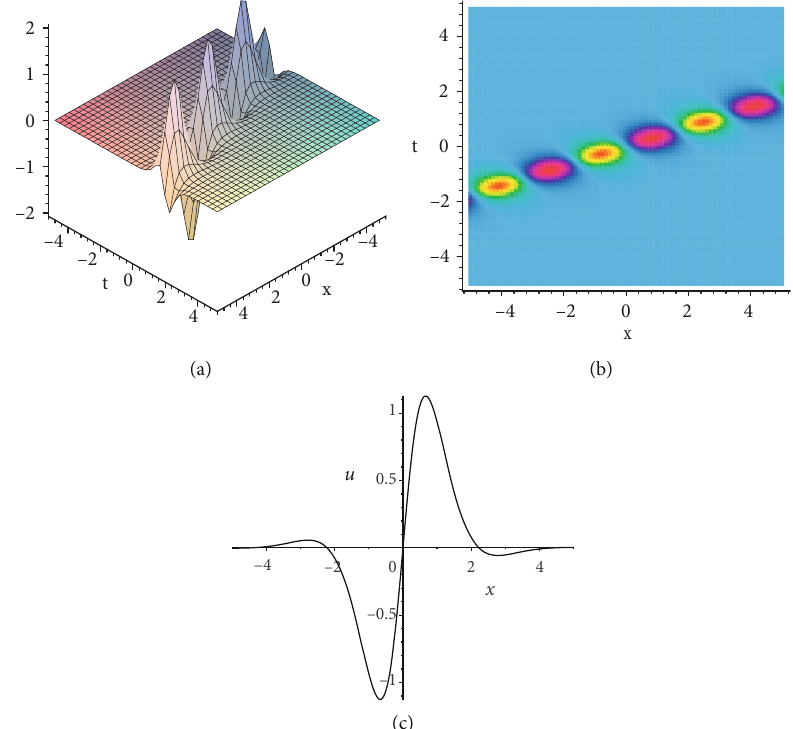
ffiffiffi p ffiffiffi p 2 − 4 , c = 1 , α = 2 , β = γ = 0 ,